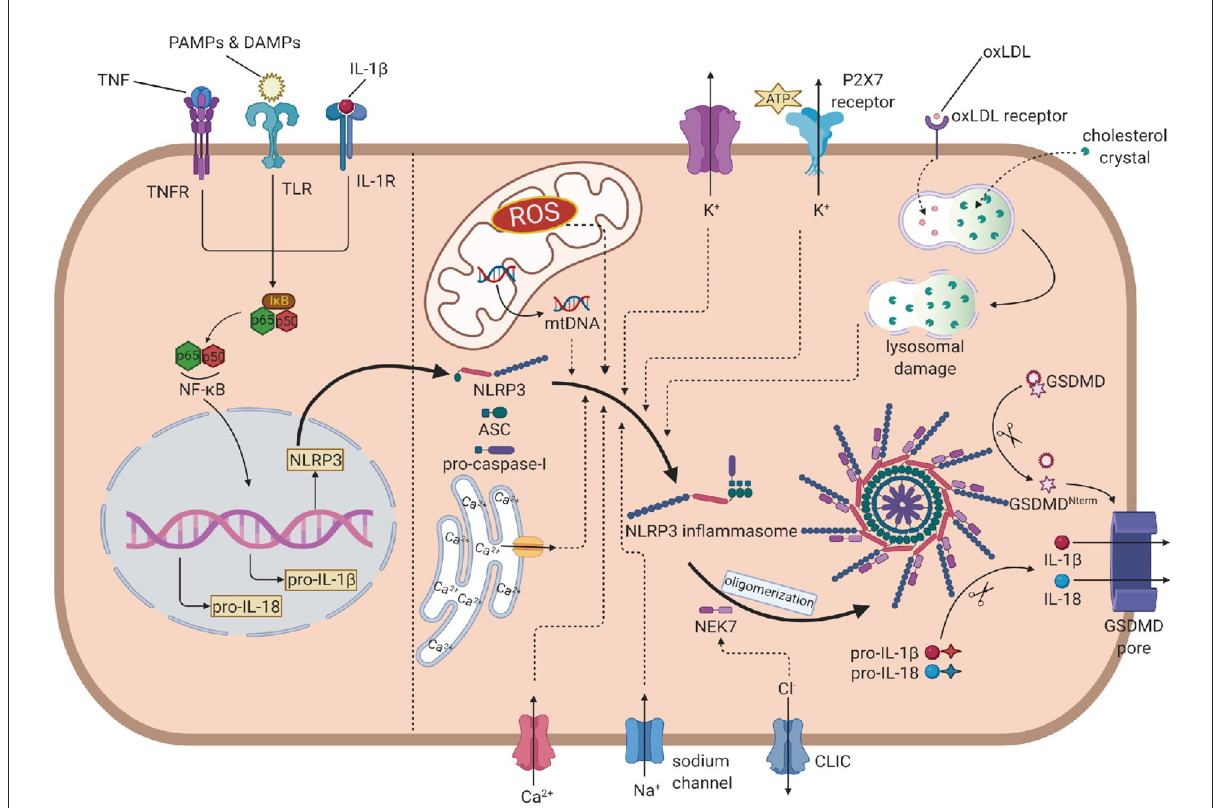
FIGURE1 The overall mechanism of the NLRP3 inflammasome activation. In the priming step, PAMPs, DAMPs, IL-1 β and TNF induce the phosphorylation and lysis of inhibitor of NF- κ B (I κ B), activate the NF- κ B pathway, leading to the transcription of NLRP3, pro-IL-1 β and pro-IL-18. In the activation process, NLRP3 recruits ASC, which links to pro-caspase-1, to assembly the inflammasome. Then, NEK7 is attached to inflammasome and induces the oligomerization. The efflux of K + , influx of Na + and Ca2 + (from extrecellular and endoplasmic reticulum), ROS, mtDNA and oxLDL or cholesterol crystal- induced lysosomal damage contribute to the assembly. The efflux of Cl- promotes the attachment of NEK7 and then the oligomerization. Caspase-1 is activated by autoproteolysis on oligomeric NLRP3 inflammasome, cleaving pro-IL-1 and pro-IL-18 into IL-1 and IL-18. Caspase-1 also cleaves GSDMD to form the GSDMD pore, leading to the release of IL-1 and pyroptosis. NLRP3, nucleotide oligomerization domain (NOD)-, leucine-rich repeat (LRR)- and pyrin domain (PYD)-containing protein3; PAMP, pathogen- associated molecular patterns; DAMP, damage associated molecular patterns; TNF, tumor necrosis factor; NF- κ B, nuclear factor κ -light-chain enhancer of activated B cells; ASC, apotosis-associated speck-like protein containing a CARD; NEK7, NIMA-related kinase 7; NIMA, never in mitosis gene A; ROS, reactive oxygen species; oxLDL, oxidized low-density lipoprotein; GSDMD, gasdermin